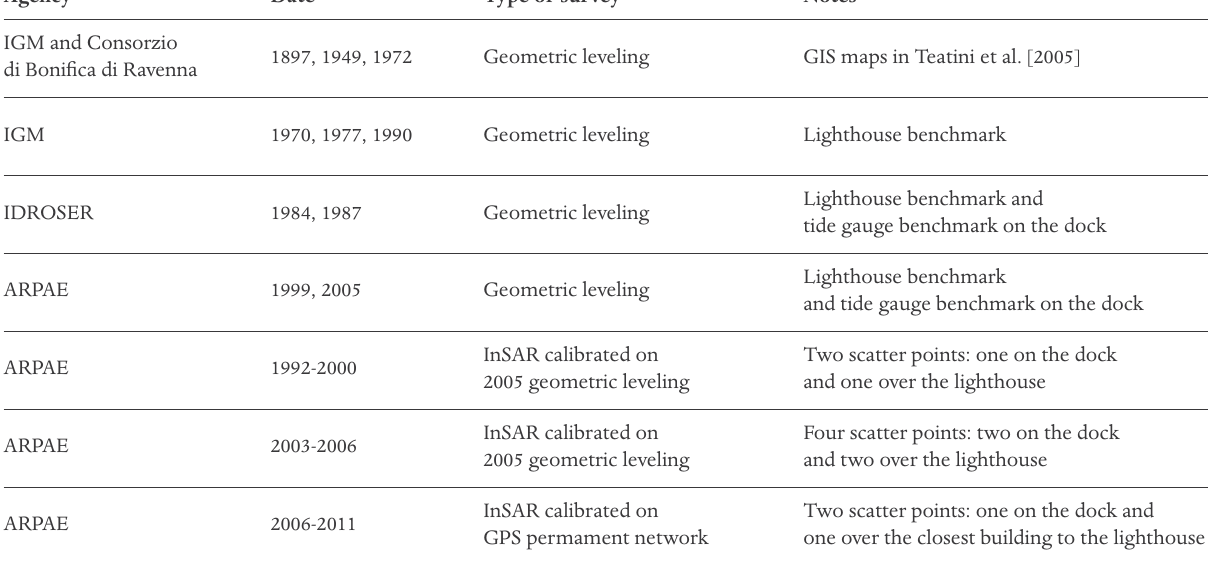
Table 1. Main surveys carried out in the Marina di Ravenna area by various agencies, with data used in the present